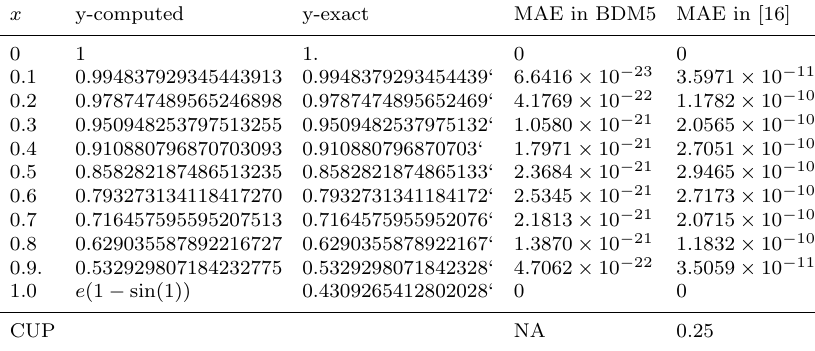
Table 7. Comparison of observed absolute errors on Example 3 with h = 1 / 10.